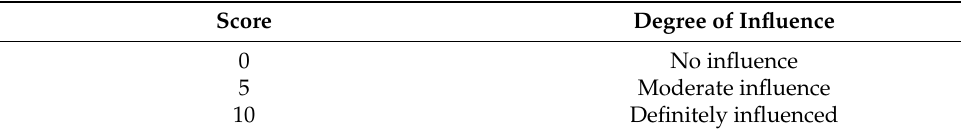
Table 3. Rubric for evaluating degree of influence.